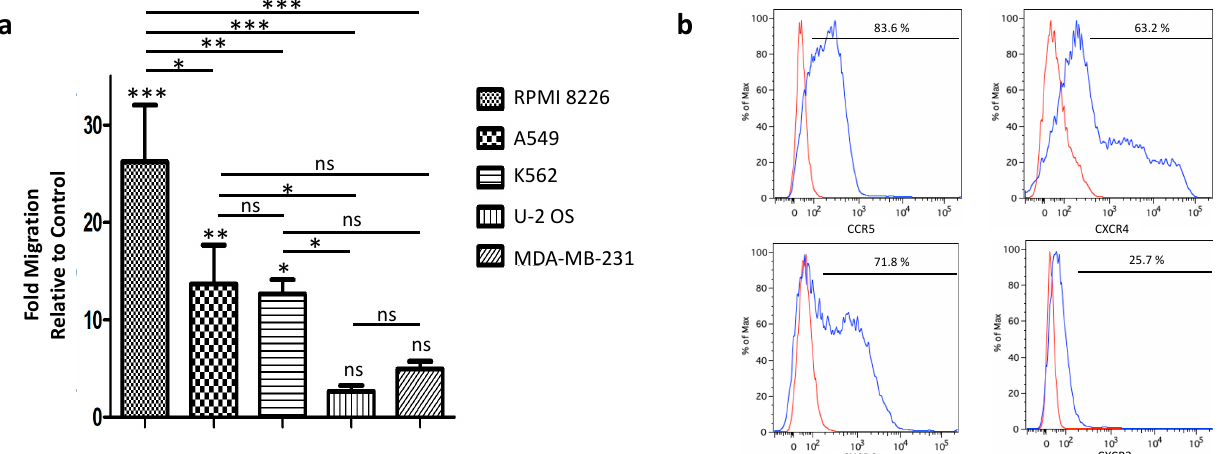
Figure 3. Migration capacity of expanded PBNK cells towards different cancer cell lines and their chemokine receptor analysis. ( a ) Summary graph of the transwell migration assay of expanded PBNK cells towards different cancer cell conditioned media ( RPMI 8226, A549, K562, U-2 OS, and MDA-MB-23). ( b ) FACS analysis of PBNK cells for chemokine receptors CXCR3, CXCR4, CCR5, and CXCR6 (blue) and the isotype-matched controls (red). Data in ( a ) are presented as means ± SEM of three independent experiments performed in triplicate. ns, not significant, *, p < 0.05, **, p < 0.01, ***, p < 0.001, one-way ANOVA and repeated measures test.